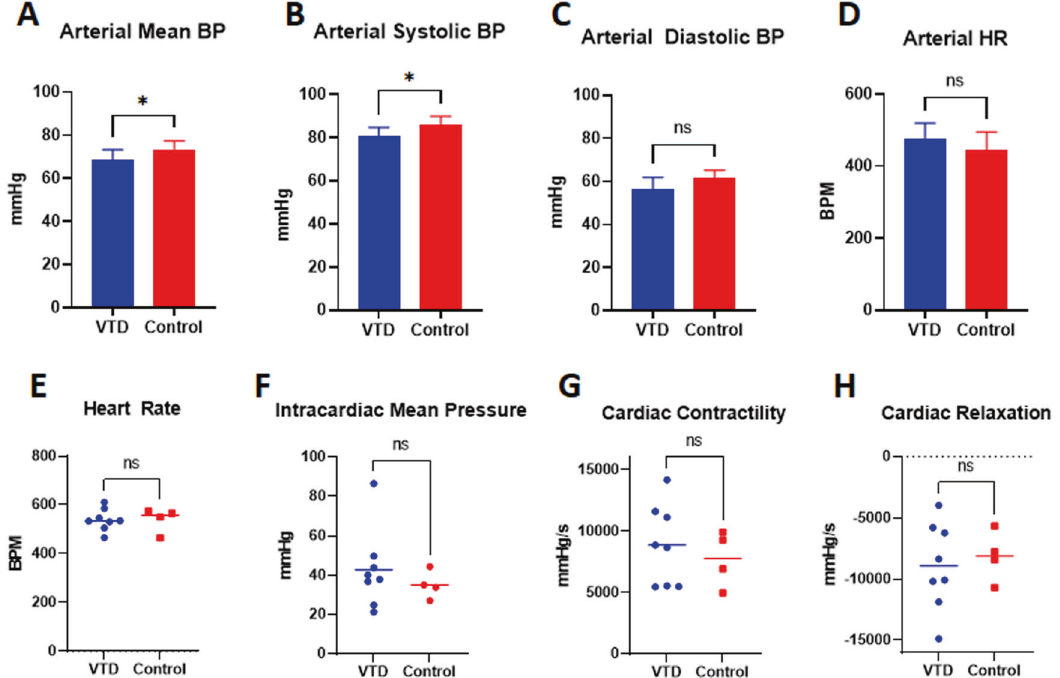
Fig. 6 Cardiovascular hemodynamic assessments reveal a mild reduction in mean blood pressure. Arterial and intracardiac hemodynamic assessments were conducted at endpoint after treatment with 0.1 mg/kg VTD QOD for 30 days. A – E Carotid arterial blood pressure at the 4-week endpoint revealed a signi fi cant but mild decrease in arterial mean blood pressure (Panel A) with VTD treatment. This was due to a reduction in arterial systolic (Panel B ) but not diastolic (Panel C ) blood pressure. Arterial heart rate was unaffected (Panel D ). Results are expressed as mean ± SEM ( N = 4 – 8 per group, * P < 0.05). E – H Intracardiac pressure-volume loop (PV loop) analysis at the 4-week endpoint revealed no signi fi cant difference for heart rate (Panel E ), mean pressure (Panel F ), contractility (Panel G ), or relaxation (Panel H ). Results